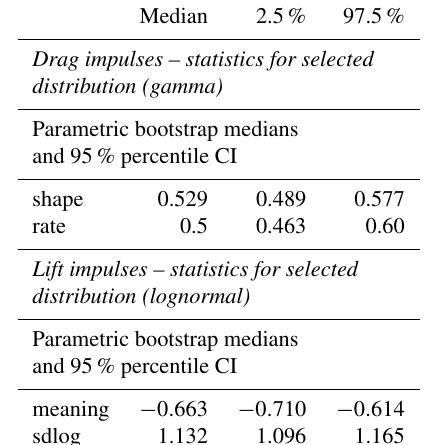
Table F2. Statistics for selected